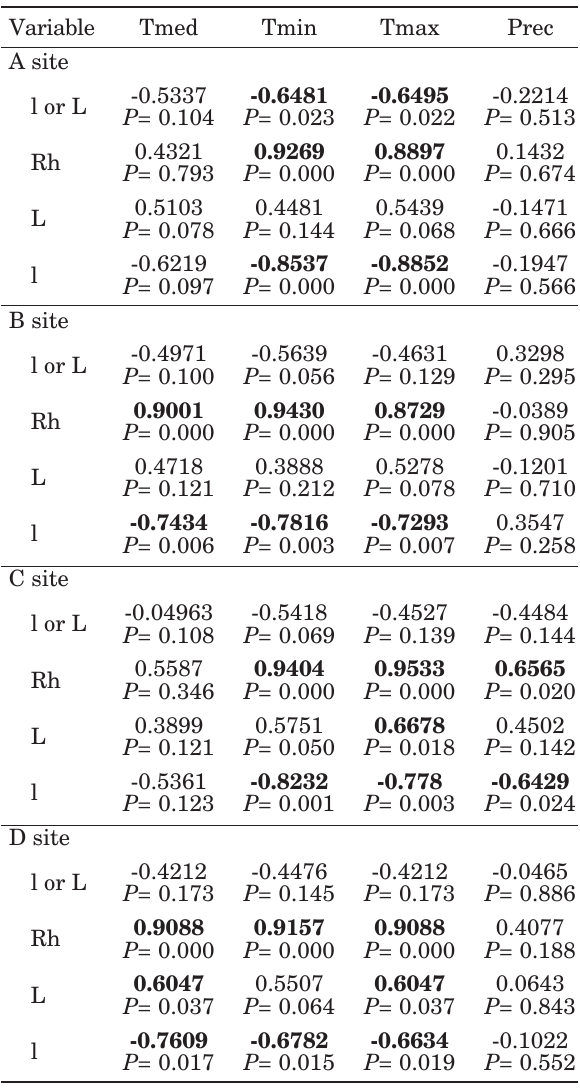
Table 1. Significant results of the Kruskal-Wallis non pa - rametric test ( P <0.05, n=30). Only significant differences among the mean values of the frequencies of 3 fructifica - tions, according to the 3 tree growth stages, are given.